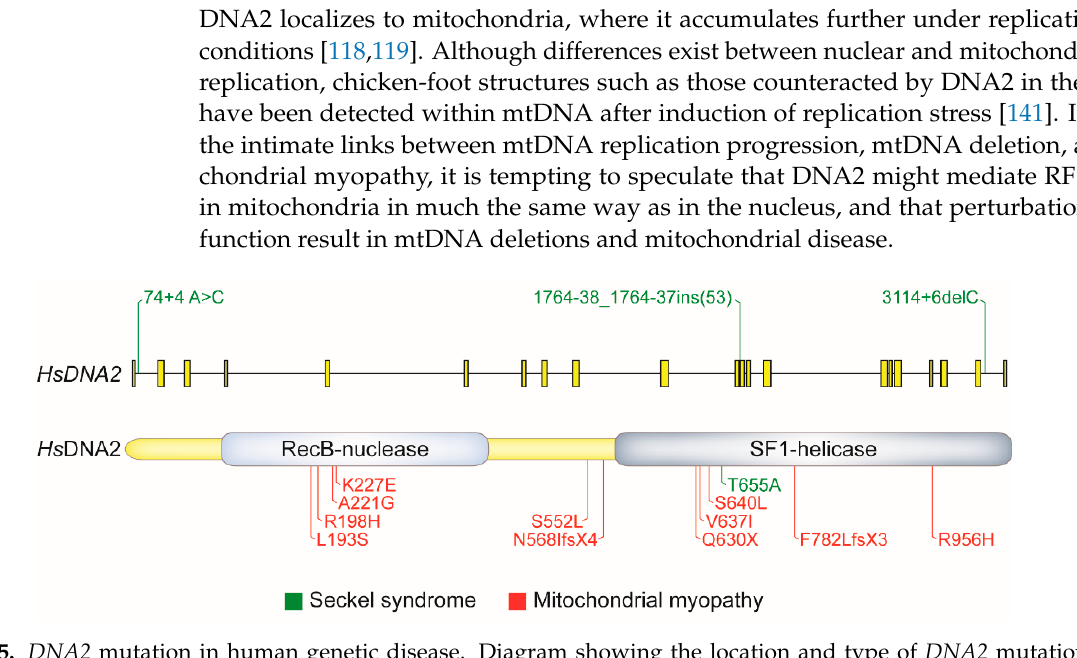
Figure 5. DNA2 mutation in human genetic disease. Diagram showing the location and type of DNA2 mutations in mitochondrial myopathy and Seckel syndrome. Gene structure showing introns and exons ( top ) and DNA2 protein domains ( bottom ) are depicted (SF1, superfamily 1). Mutations occurring in introns are marked on the gene, whereas coding mutations are marked on the protein with the resulting amino acid changes indicated.